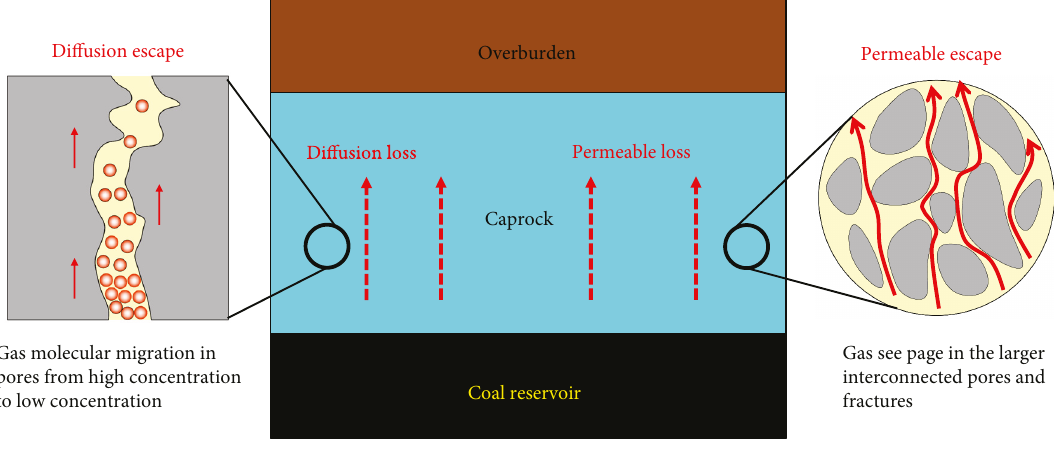
Figure 11: Conceptional diagram showing the sealing mechanism of caprocks and its e ff ect on CBM